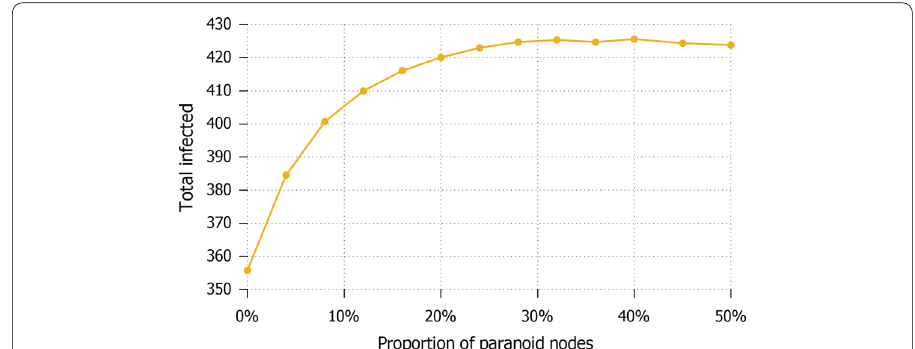
Fig. 13 Proportion of paranoid nodes (a) Different paranoid nodes distribution compared with the number of total